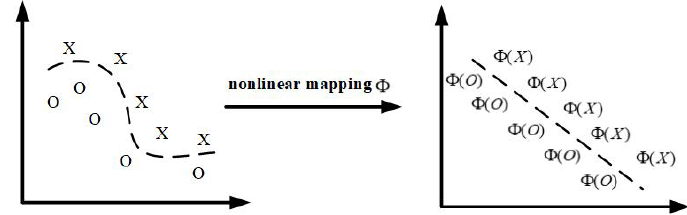
Figure 4. Nonlinear mapping.